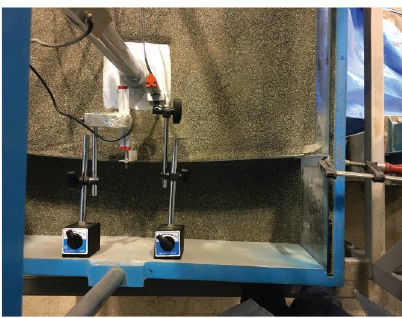
Figure 8: State of SPW after load